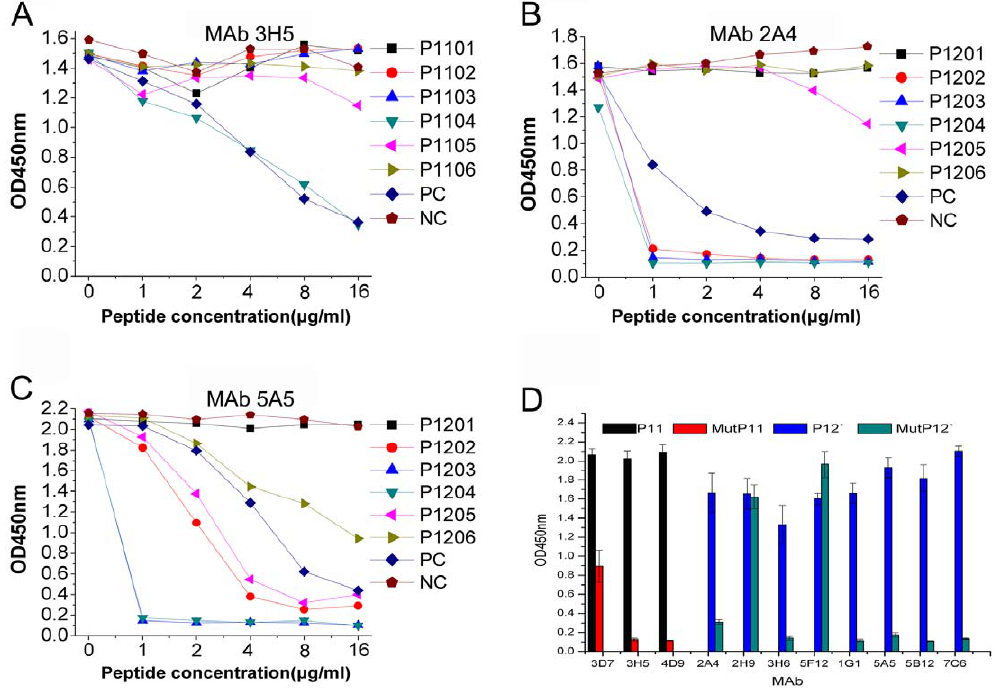
Figure 2. Competitive binding of mAb to the 16mer peptide inhibited by 9mer or mutated peptides in Peptide-ELISA. (A) P11 and mAb 3H5; (B) P12 and mAb 2A4; (C) P12 and mAb 5A5. A volume of 50 m l of supernatants of mAb 2A4, 3H5 or 5A5 cell cultures was pre-mixed with 50 m l of each 9mer peptide dilution (P1101 to P1106 or P1201 to P1206 and control peptides) at concentration of 0, 2, 4, 8, 16 and 32 m g/ml. A volume of 100 m l of the mAb and peptide mixture was added to the 16mer peptides P11 or P12 coated wells. P11 or P12 was used as an inhibitive (positive) control (PC), respectively. One HCV NS3 peptide was used a non-inhibitive (negative) control (NC). (D) Binding of mAbs to P11 and P12 9 compared with their mutated peptides MutP11 and MutP12 9 .